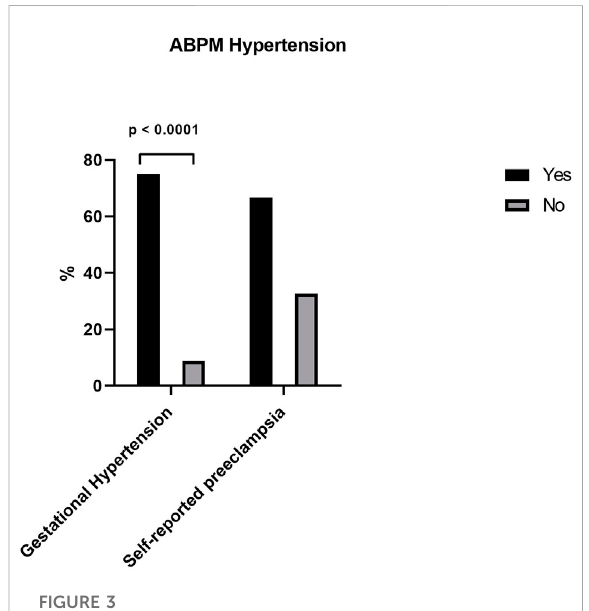
FIGURE 3 ABPM Hypertension between gestational hypertension and self reported hypertension.